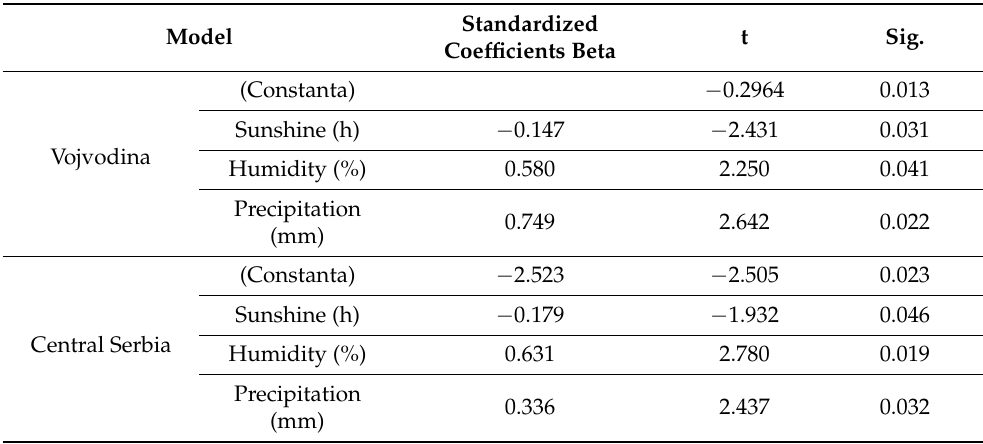
Table 5. The comparioson of coefficient relationship between climatic elements and maize yield in two location in the Republic of Serbia for the period 2005–2020.